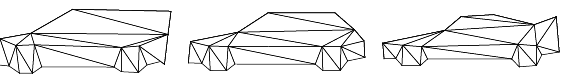
Figure 3. 3D Active Shape Models. Center: mean shape, γ = (0 , 0) and two deformations, left: γ l = (1 . 0 , 0 . 8) , right: γ r = ( − 1 . 0 , − 0 . 8)